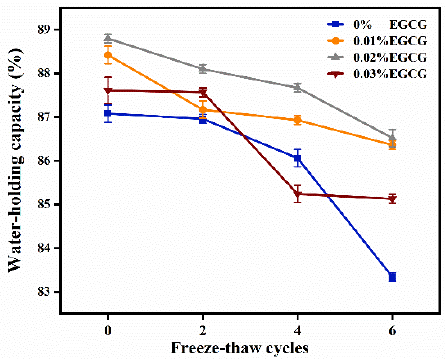
Figure 4. Changes in WHC of surimi gels treated with different content EGCG during F-T